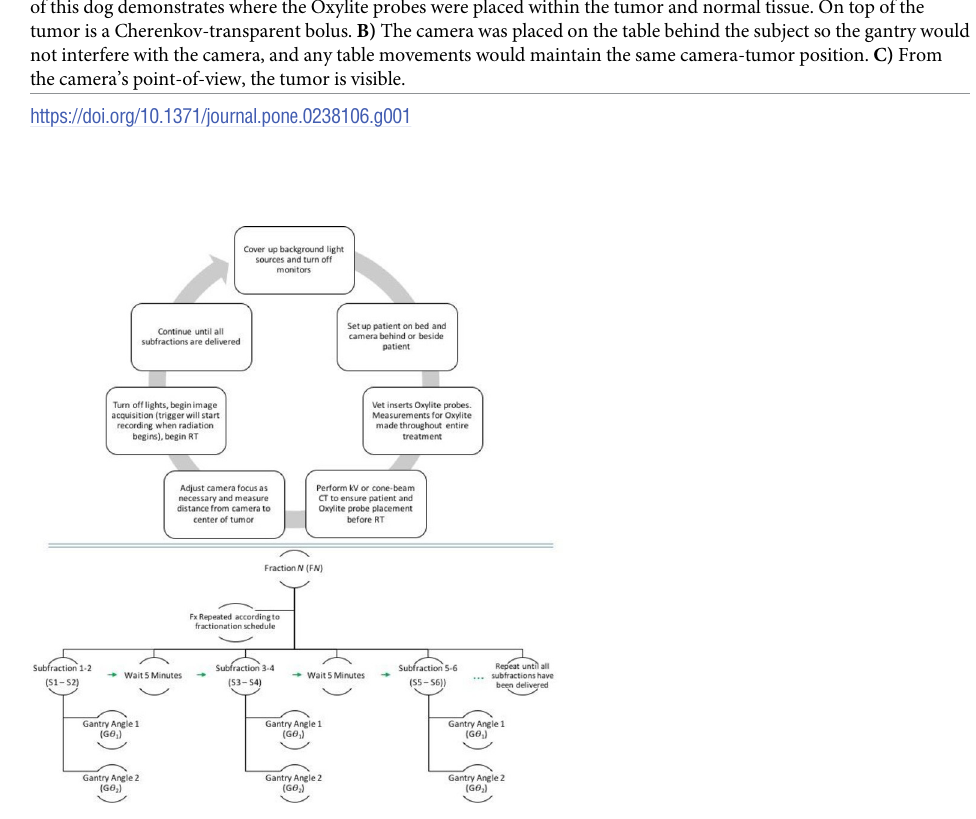
Fig 2. RT and Cherenkov-imaging workflow. One of our aims was to determine if integration of this camera system with the RT workflow is achievable. We found the workflow to be simple. Once the camera was setup, the imaging required just two extra steps: (1) turning off the room lights for the duration of the RT fraction; and (2) pressing the acquisition button in the software. For this study, we simply observed biology that occurred during a standard radiation dose fraction; however, to maximize the amount of data that could be acquired per dog; the individual dose fraction was broken into several equally-sized subfractions that were each given at a standard dose rate (600 monitor units per minute) but temporally separated by 5